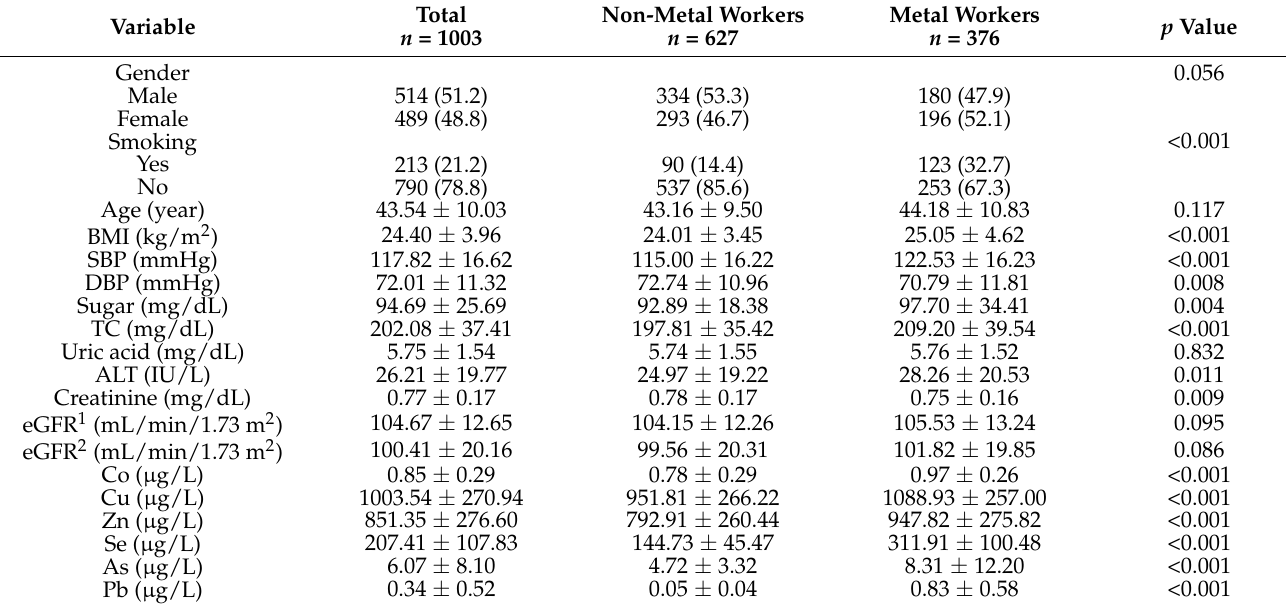
Table 1. Comparison of demographic characteristics, physical and biochemical parameters, and plasma metal concentrations between the non-metal industrial workers and metal industrial workers.